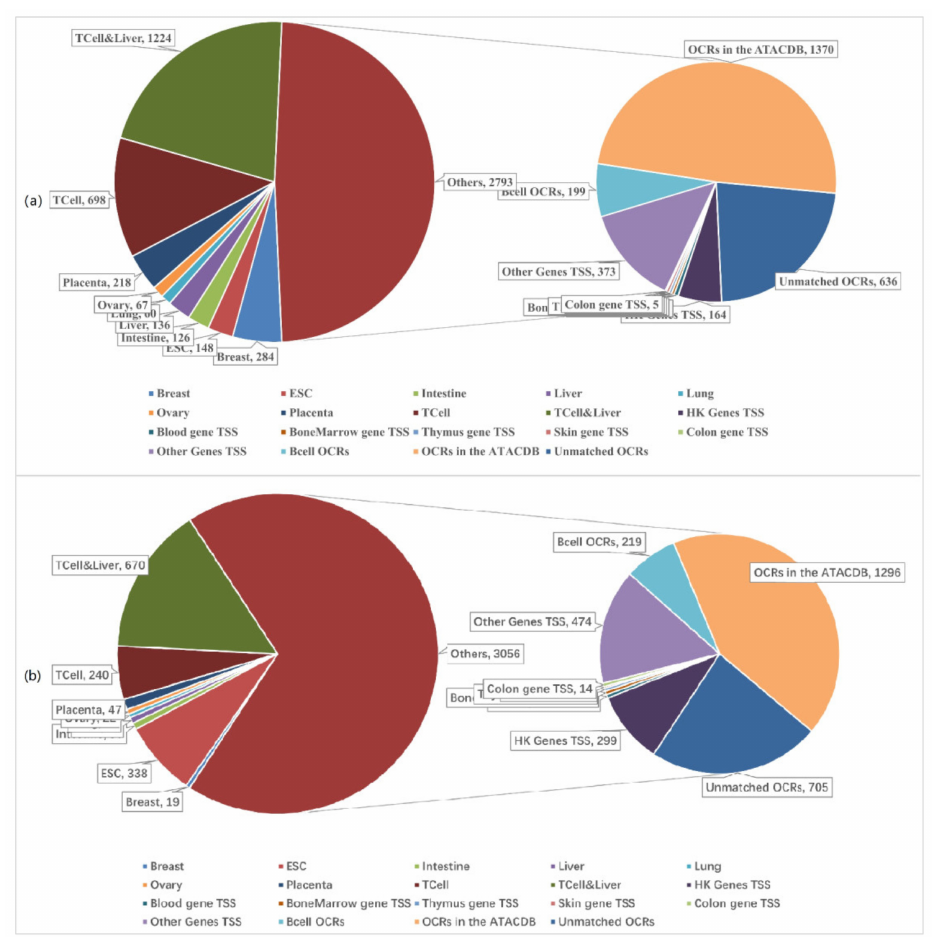
Figure 6. ( a ) The composition of the OCRs obtained from liver cancer cfDNA-seq data. ( b ) The composition of the OCRs obtained from the cfDNA-seq data of healthy